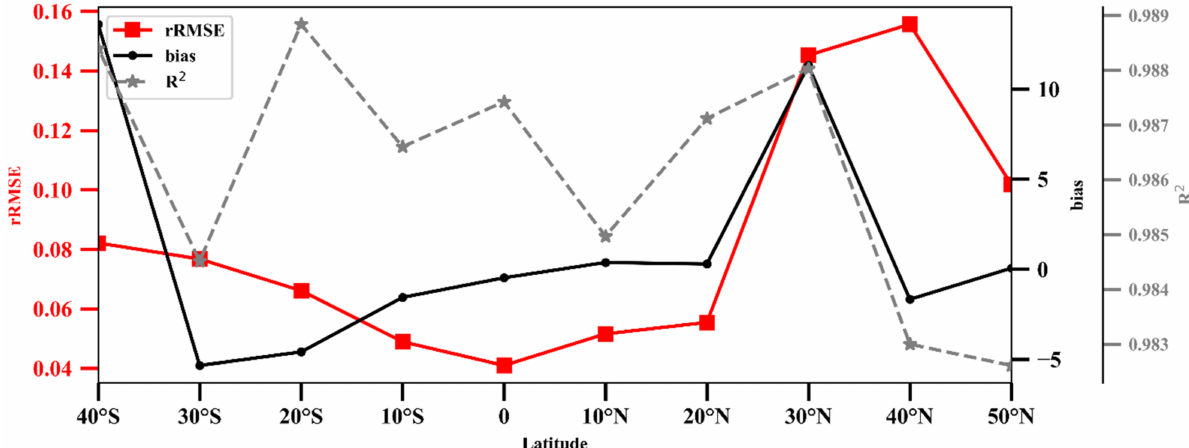
Figure 13. The performances of the new models in oceans within different latitudinal zones.